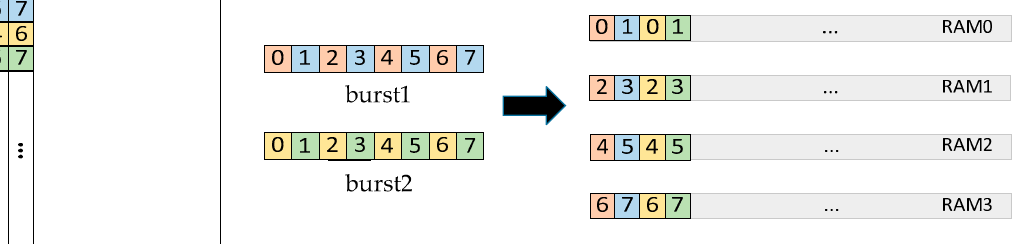
Figure 12. De-cross access and caching in azimuth direction.